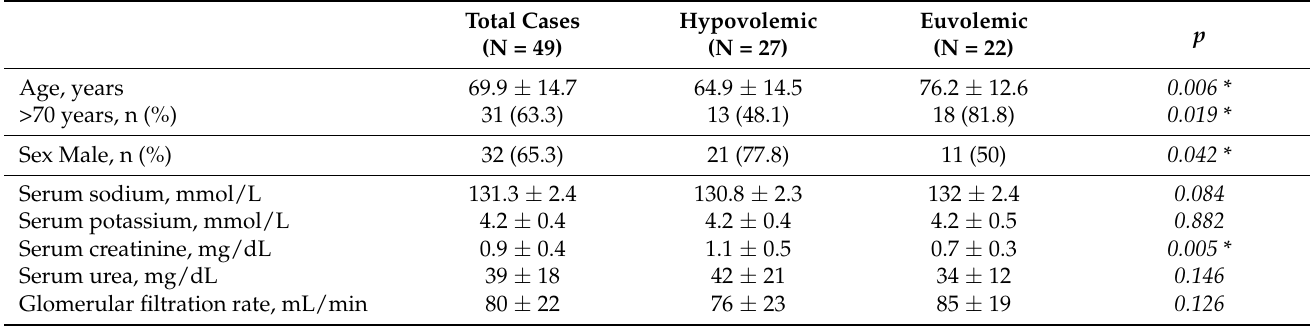
Table 1. General characteristics of patients at